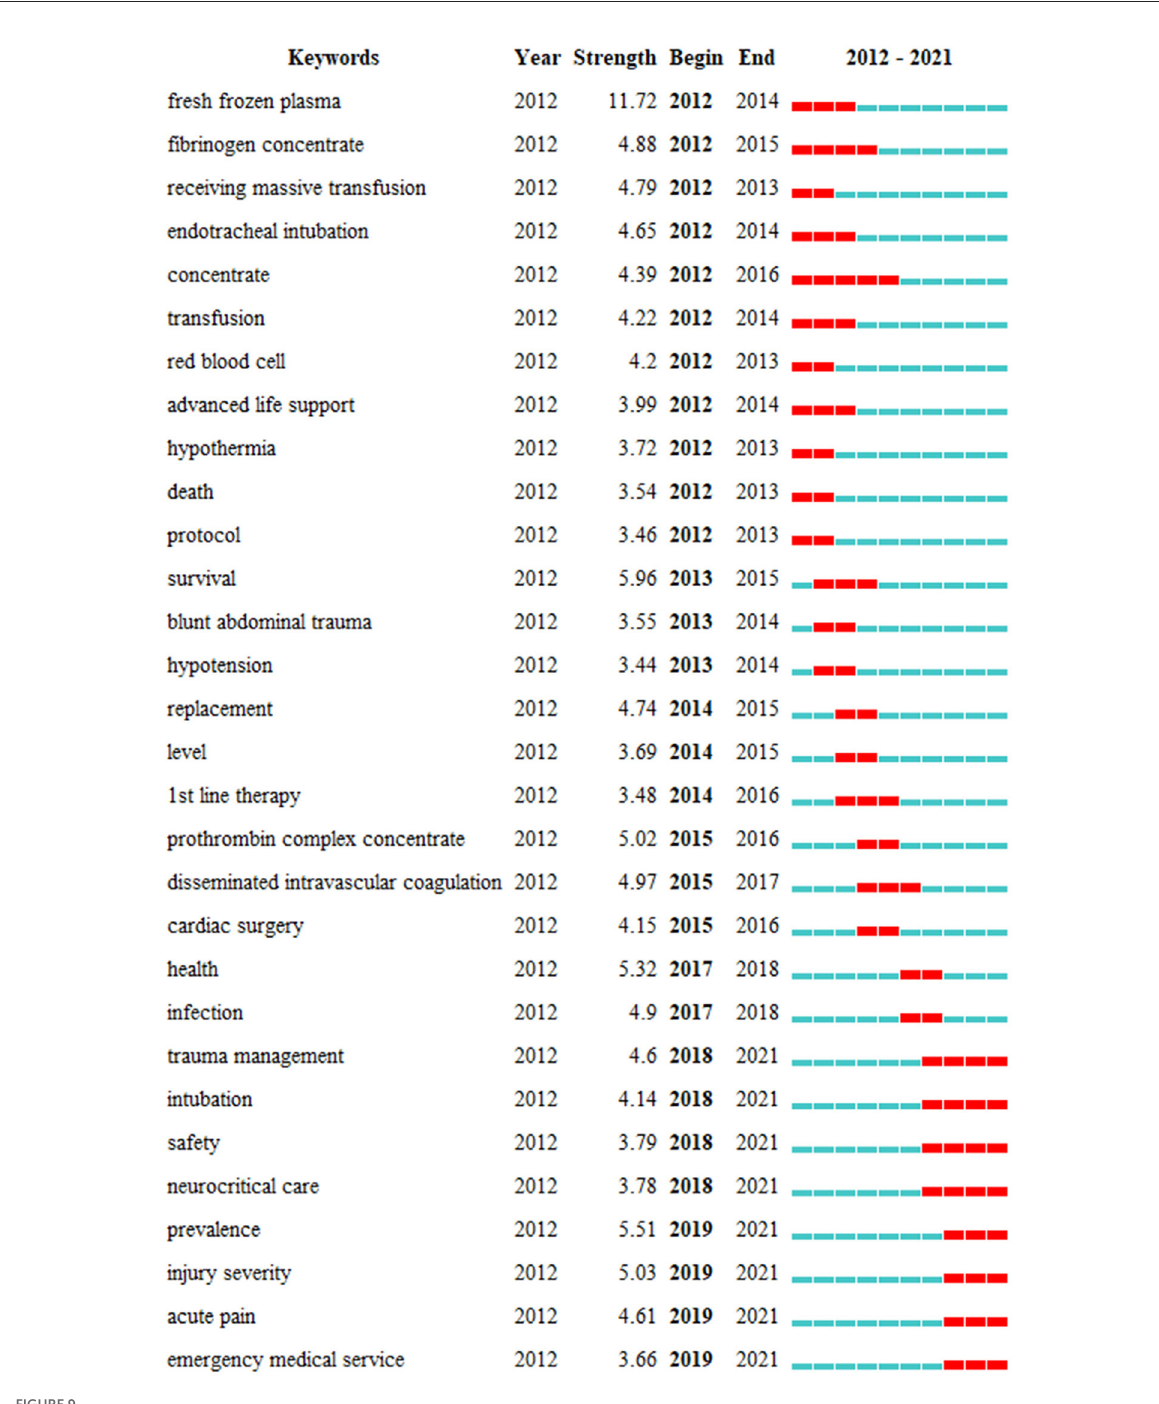
FIGURE9 Top 30 keywords with citation burst (sorted by the beginning year of the